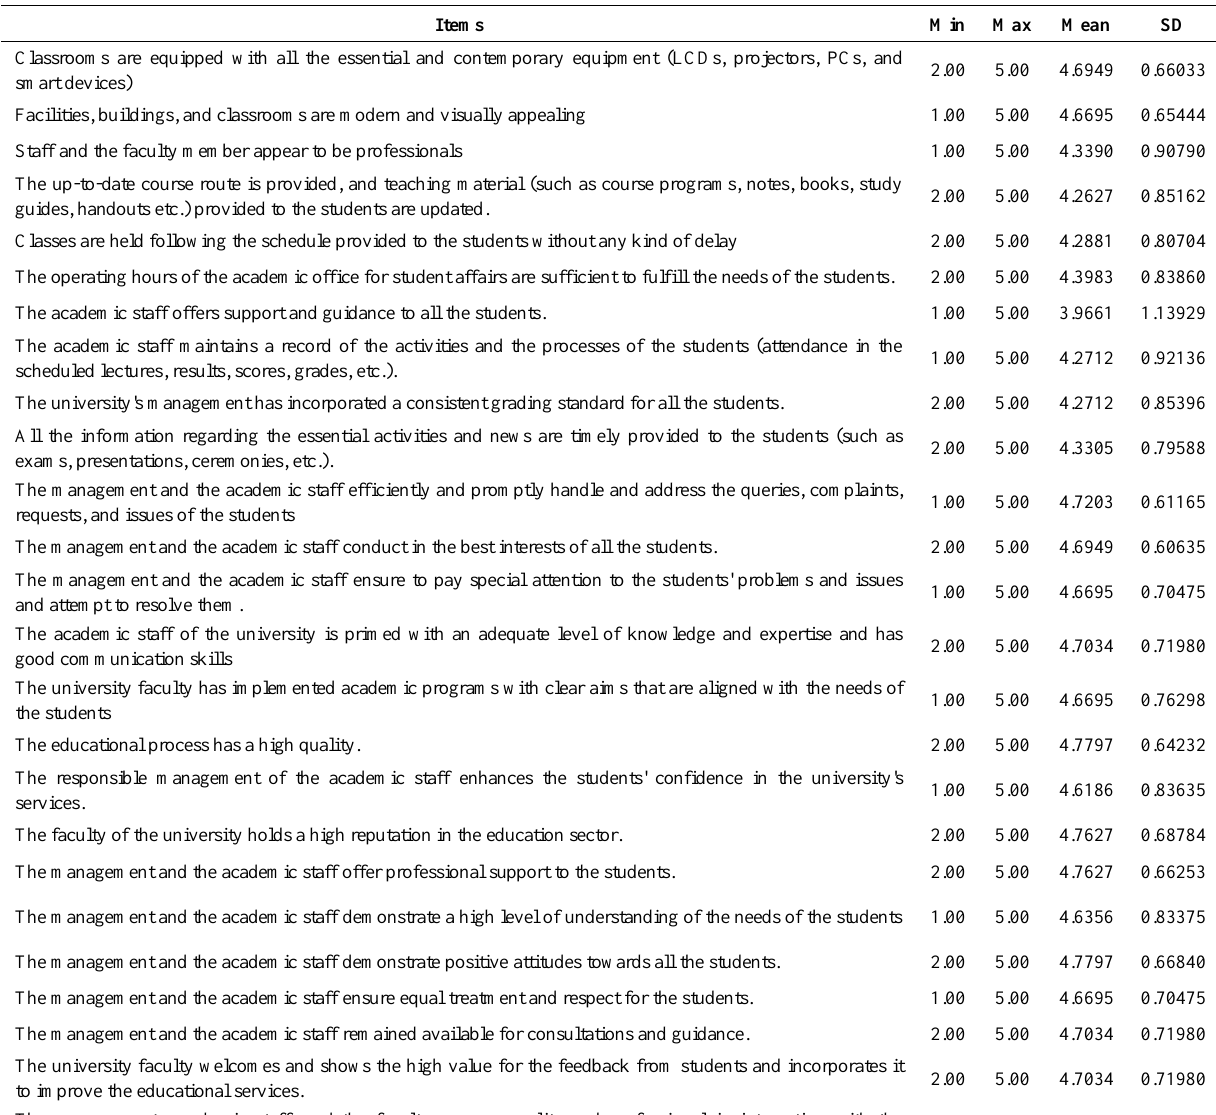
Table 6. Descriptive statistics for service quality expectations of the students in Russia Items